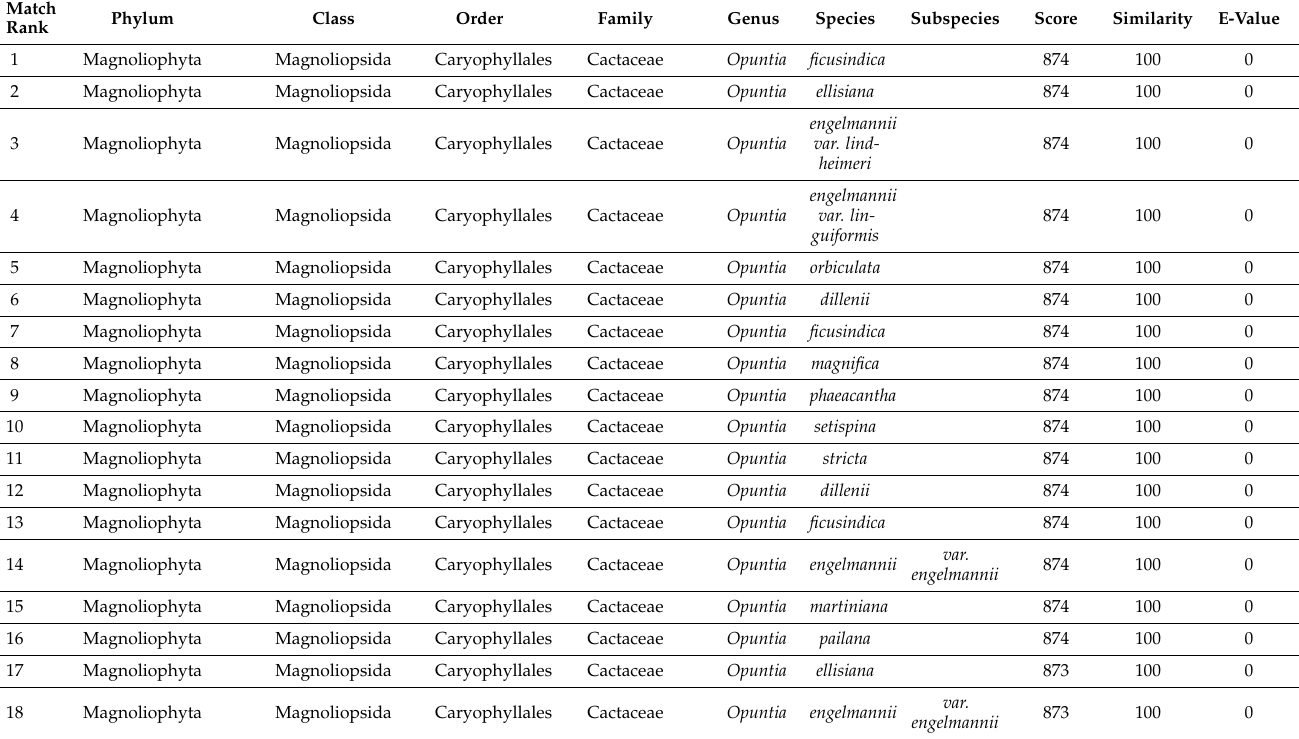
Table 3. The BOLD identification system results table for the matk gene